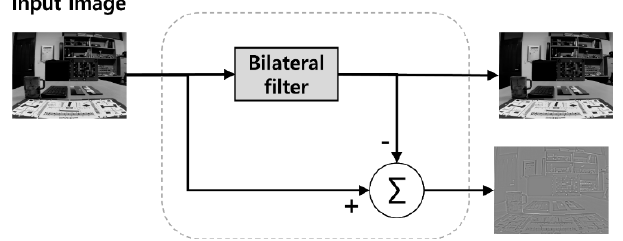
Figure 5. Image decomposition by the bilateral